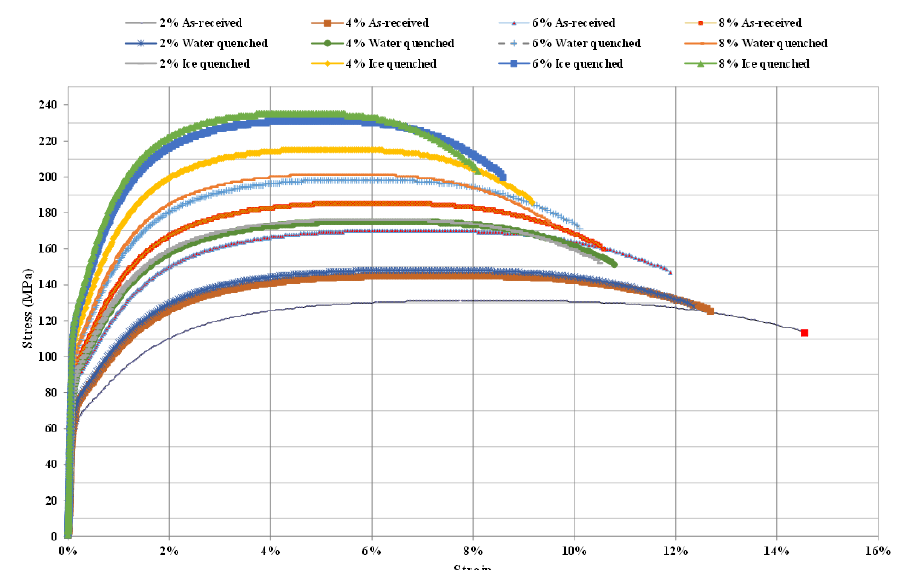
Figure 2: Stress-strain curve for as-received, water quenched and ice quenched samples.